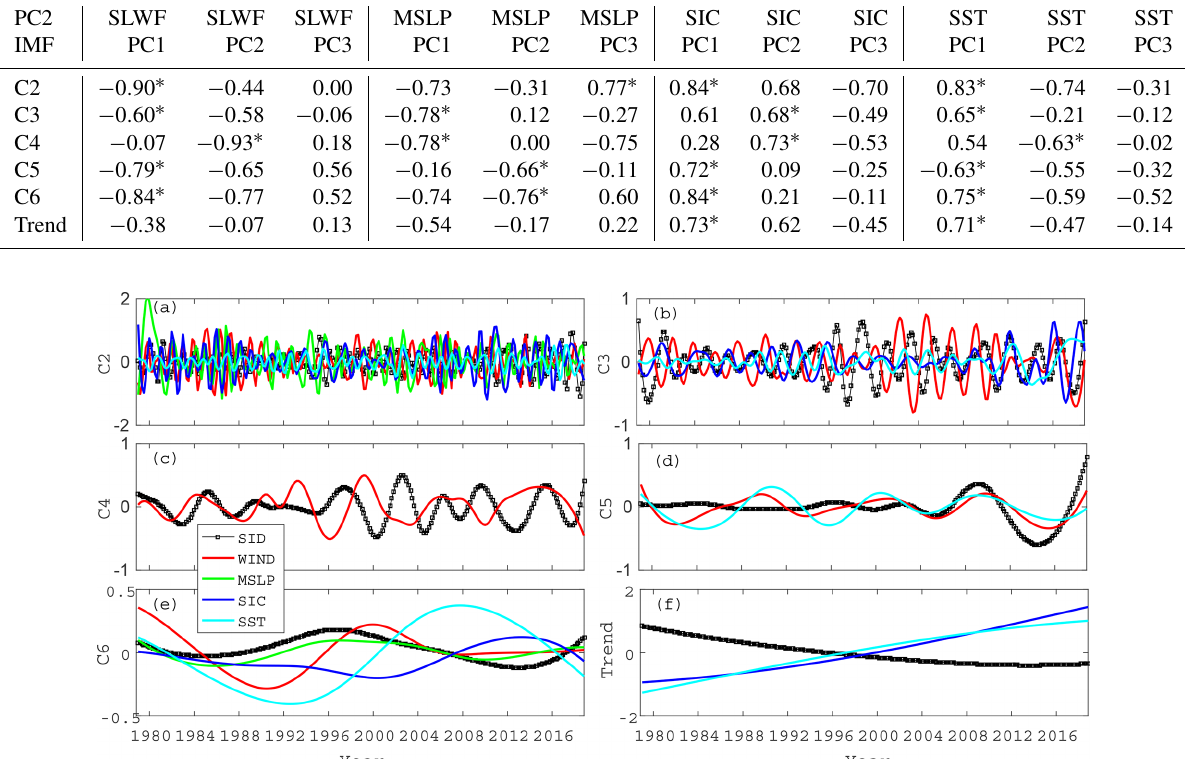
Figure 10. The IMF modes (a–e) and trend components (f) after EEMD of the third sea ice EOF temporal coefficient and each environmental parameter. (For each environmental parameter, only the EOF component marked with an asterisk is drawn.)